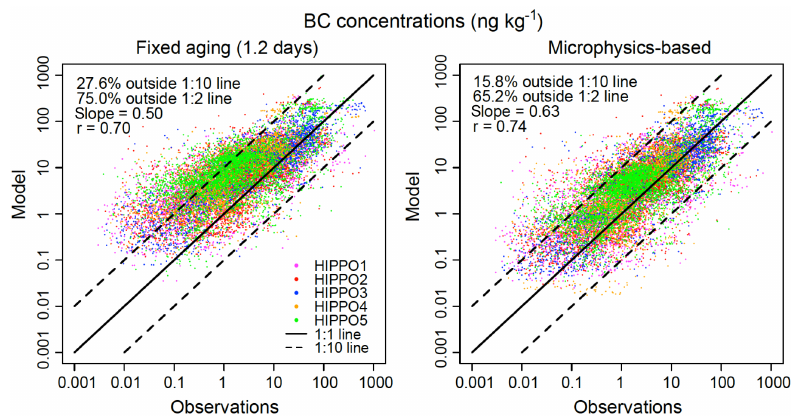
Figure 6. HIPPO observed and GEOS-Chem simulated BC concentrations sampled along the HIPPO flight tracks (HIPPO 1: pink; HIPPO 2: red; HIPPO 3: blue; HIPPO 4: orange; HIPPO 5: green; see Fig. 1), with model results using a fixed BC aging scheme (left panel) and a microphysics-based BC aging scheme (right panel). Also shown are the 1:1 and 1:10 (or 10:1) ratio lines, percentages of data points outside 1:10 (or 10:1) and 1:2 (or 2:1) ratio lines, and slopes and correlation coefficients ( r) of the regression lines between model results and observations.